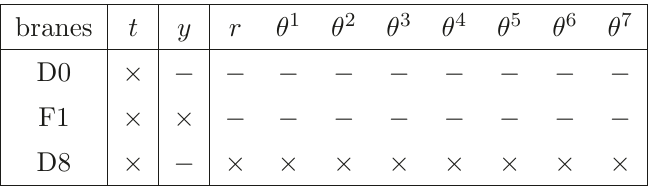
= (8 , 0) superconformal quantum mechanics de- N -BPS. We anticipate that the radial coordinate 4